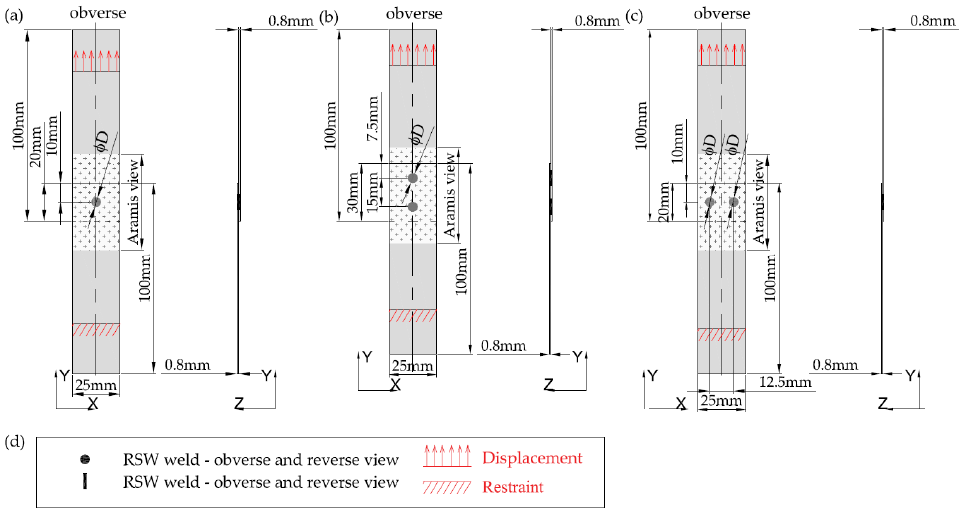
Figure 1. Geometry of the analyzed joints, mm: ( a ) joints with a single weld; ( b ) joints with two welds—parallel to the direction of tensile shear; ( c ) joints with two welds—perpendicular to the direction of tensile shear; and ( d ) legend.